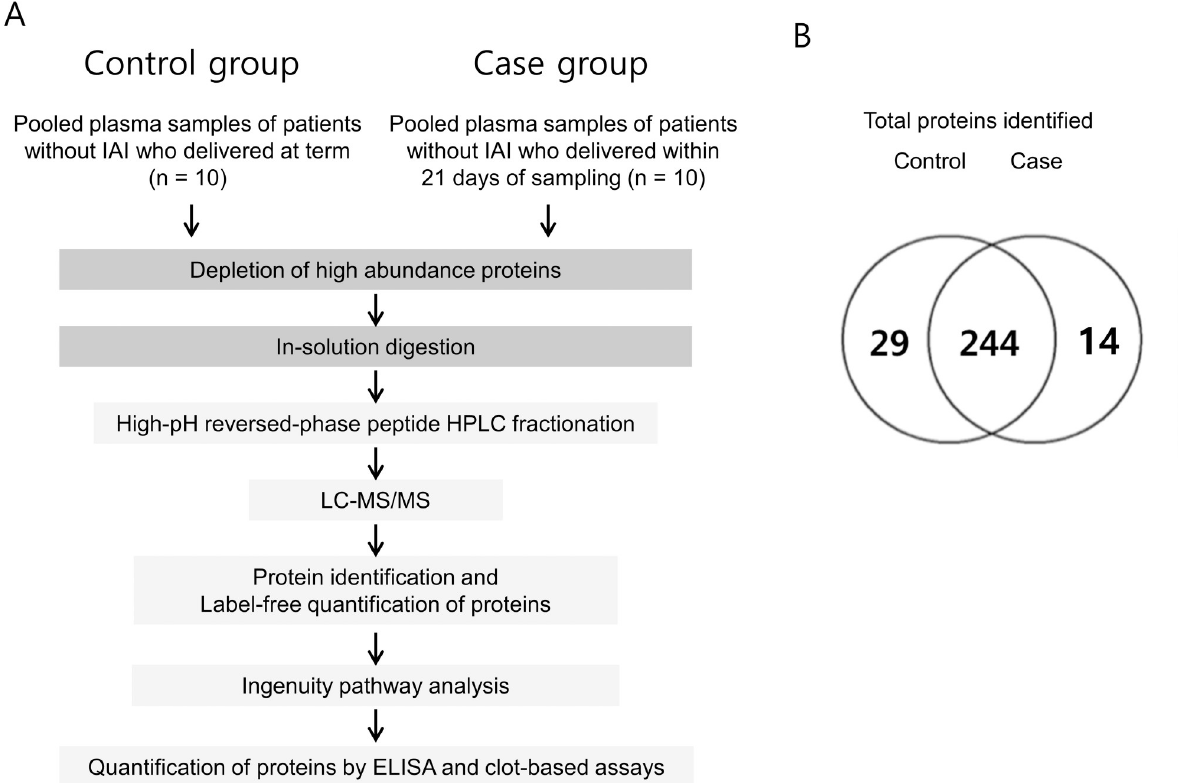
Fig 2. (A) Schematic workflow of the experimental design. Plasma samples pooled from each group (10 samples per group) were subjected to immunoaffinity depletion to remove the 14 most abundant proteins. After high-pH reversed-phase fractionation of the peptides obtained with the tryptic digestion of each sample group, the peptides were subjected to LC-MS/MS followed by label-free quantitative analysis based on spectral counting. Differentially expressed proteins (DEPs) were functionally annotated using the IPA software, and the DEPs of interest were verified using the ELISA and clot-based assay. (B) Venn diagrams showing the distribution of proteins identified in the LC-MS/MS analyses. Case: patients without infection/inflammation who delivered spontaneously within 21 days of sampling; Control: patients without infection/inflammation who delivered at term. IAI, intra-amniotic